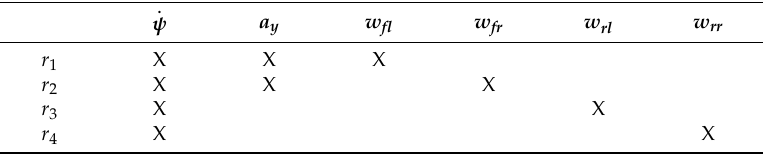
Table 1. Parameters semi-correlation table of wheel angular speed residuals.